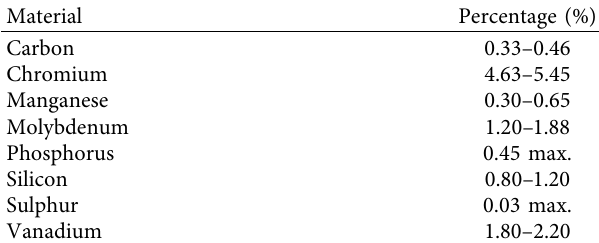
Table 1: Composition of H13 tool